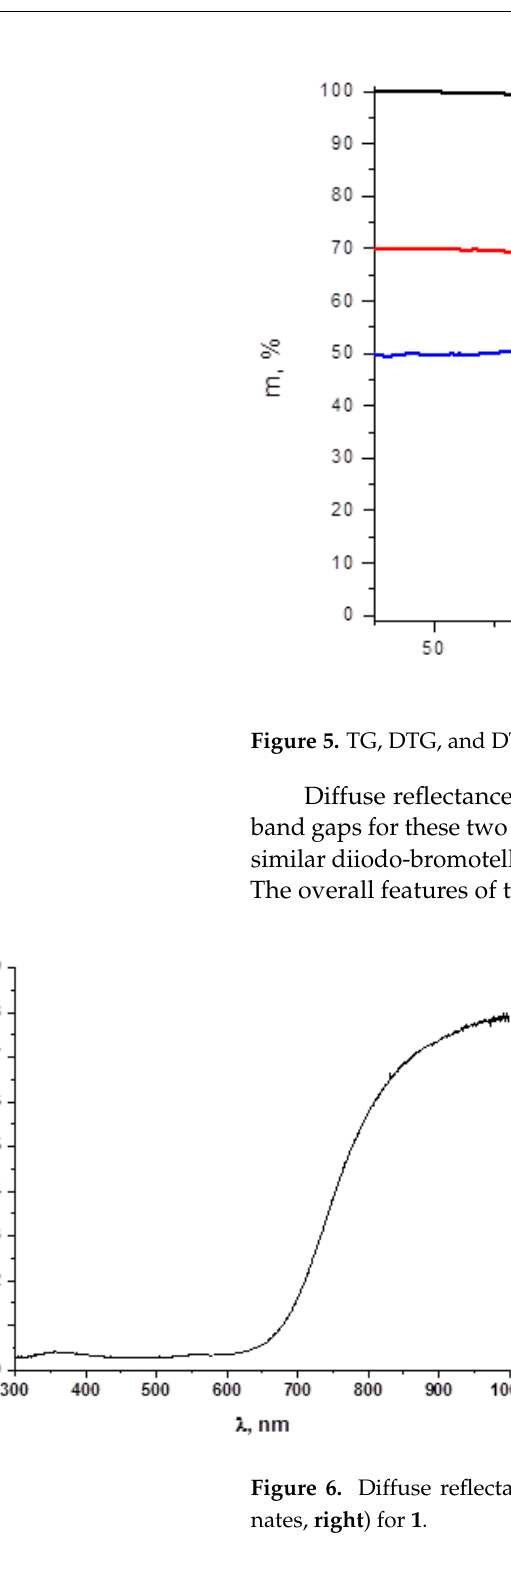
Figure 4. TG, DTG, and DTA curves of 1 .